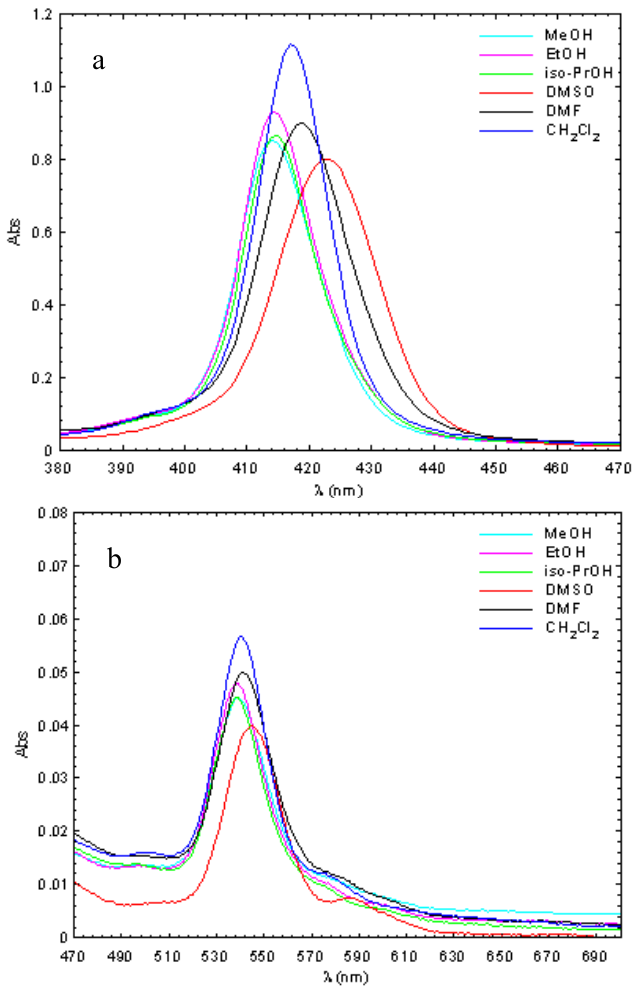
Figure 3. Absorption spectra of 5-(4-hydroxyphenyl)-10,15,20– tris -(4-carboxymethyl- phenyl)– 21, 23 Cu(II) porphine in different solvents (c = 2.5 × 10 − 6 M, a -Soret band; b -Q bands).